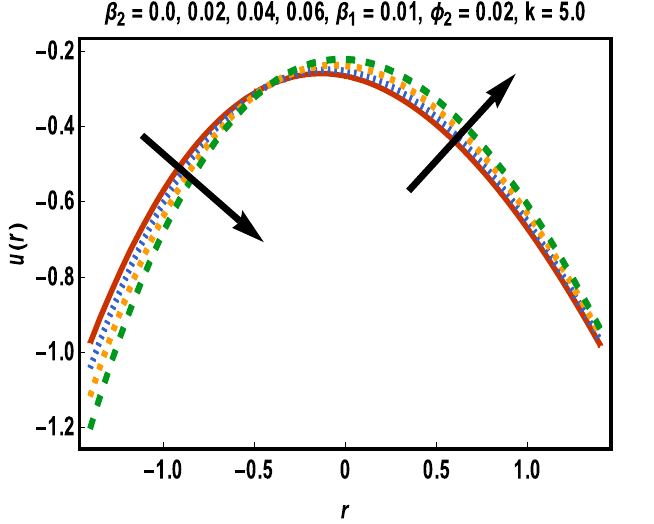
Figure 6. Results of case study 1: scenario 3 ( β 2 ).